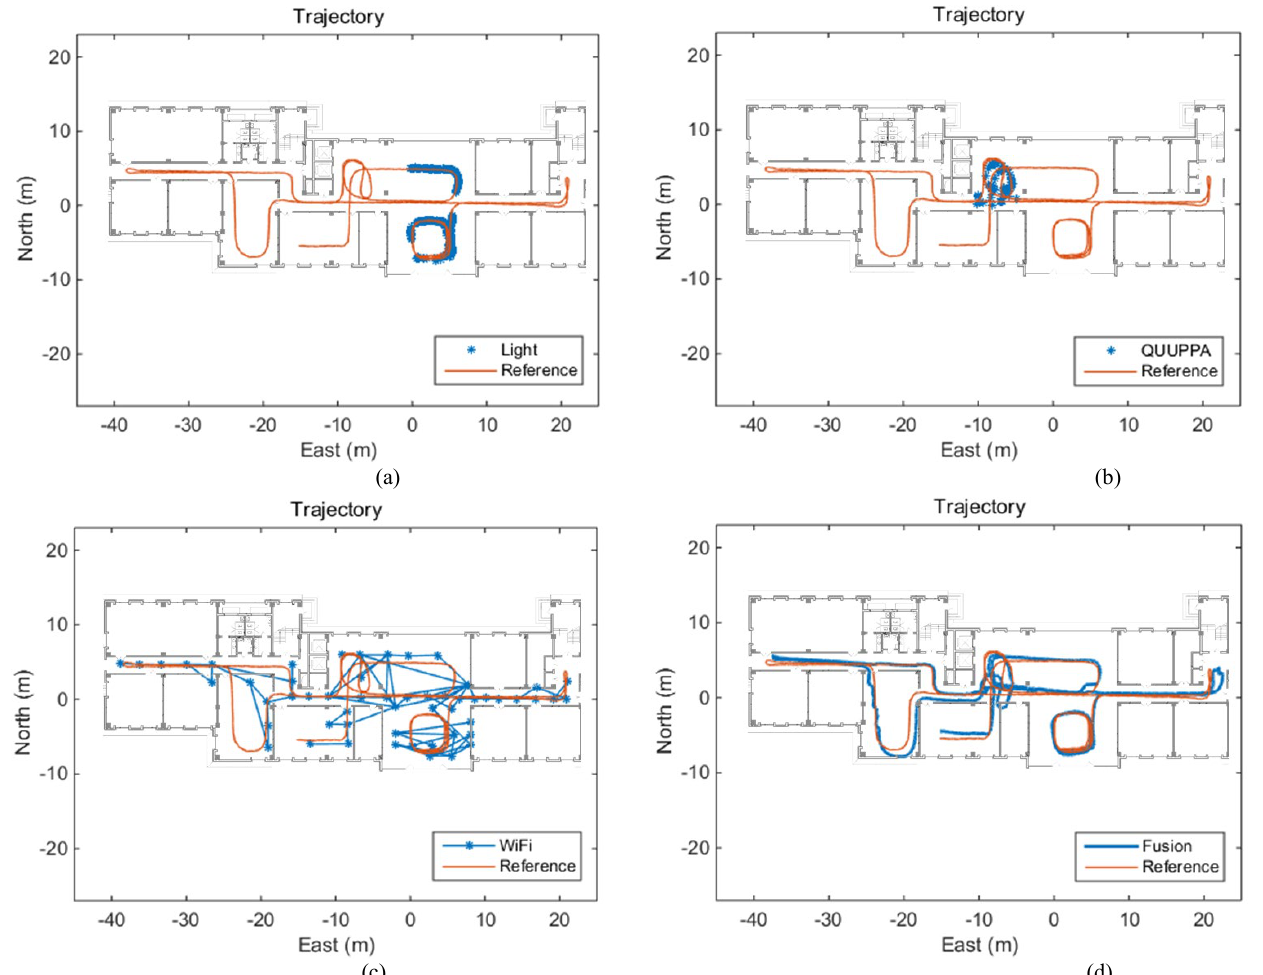
Figure 4. Walking tests of the entire floor in the scenario. (a) Trajectories of the reference and the light solution. (b) Trajectories of the reference and the QUUPPA solution. (c) Trajectories of the reference and the Wi-Fi fingerprinting solution. (d) Trajectories of the reference and the multi-sensor fusion